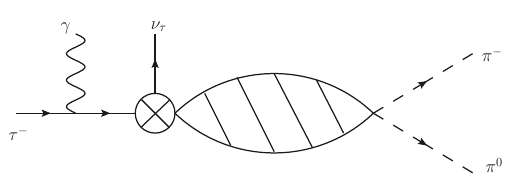
Figure 1 . Relevant Feynman diagram to the bremsstrahlung off the initial τ lepton. It is completely determined by the pion vector form factor F V ( t ) that governs the non-radiative τ → ππν τ decay process. The vector form factor F V ( t ) includes the contributions from the nonperturbative two-pion strong interactions [16, 17], denoted by the slashed